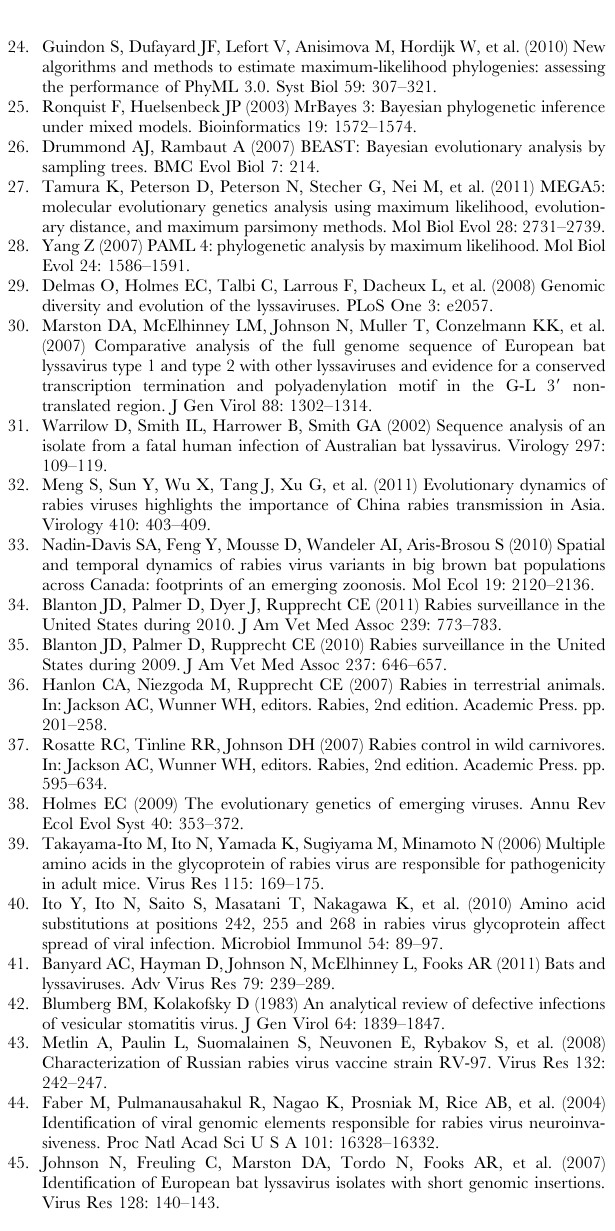
Table S2 Primers used in the present